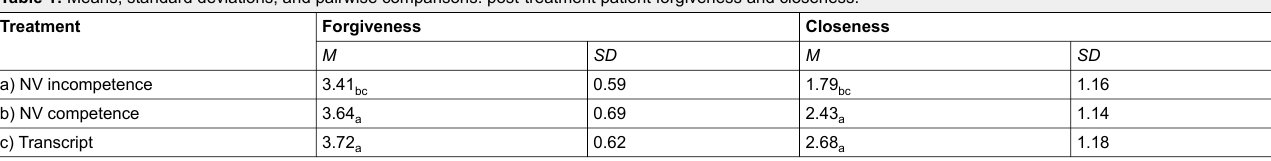
Table 1: Means, standard deviations, and pairwise comparisons: post-treatment patient forgiveness and